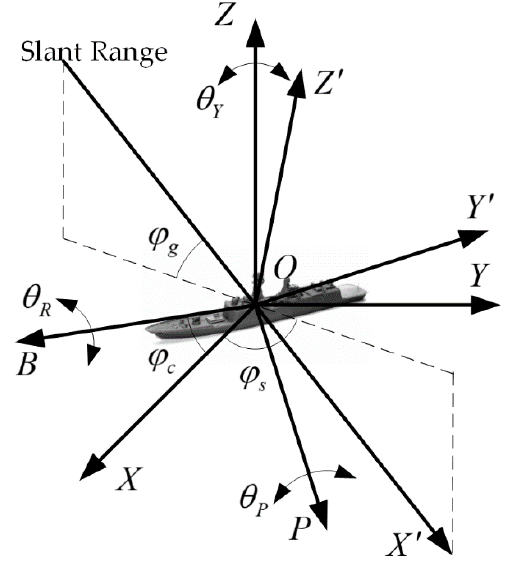
Figure 1. The geometry of a rotating ship.